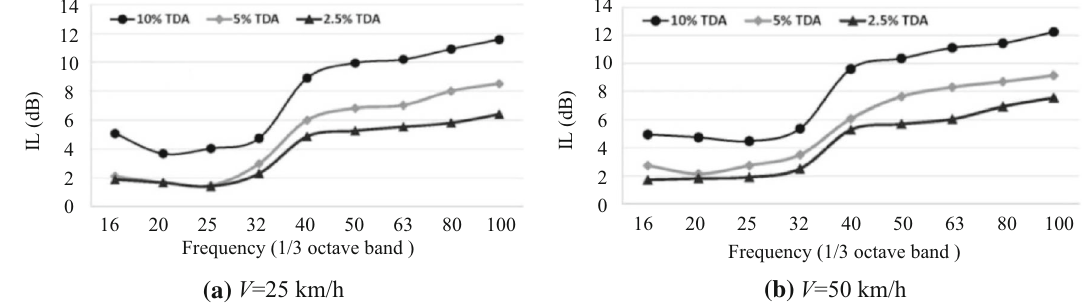
Fig. 7 Insertion loss versus frequency spectra in 1/3 octave scale of velocity vertical component at a distance of 2.5 m from track axis